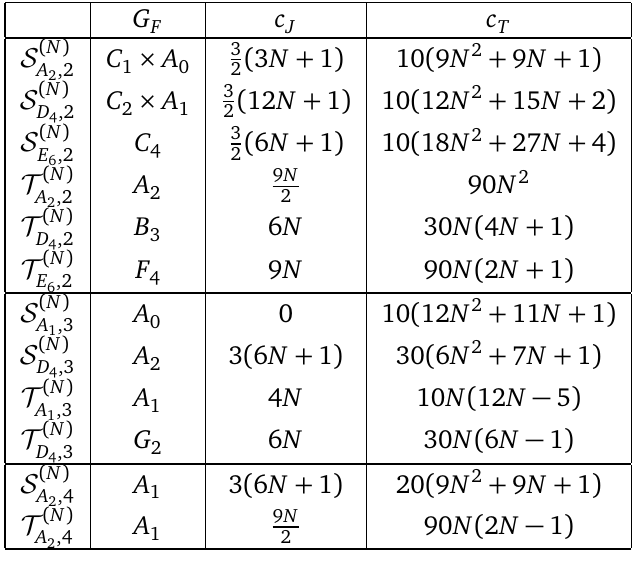
Table 3: Flavour symmetries and central charges for the twelve known classes of 4d N = 2 S-folds. See [ 41, 43 ] for more information including Coulomb branch scaling dimensions (which differ between the S breakdown of how many units of central charge are due to each factor of G